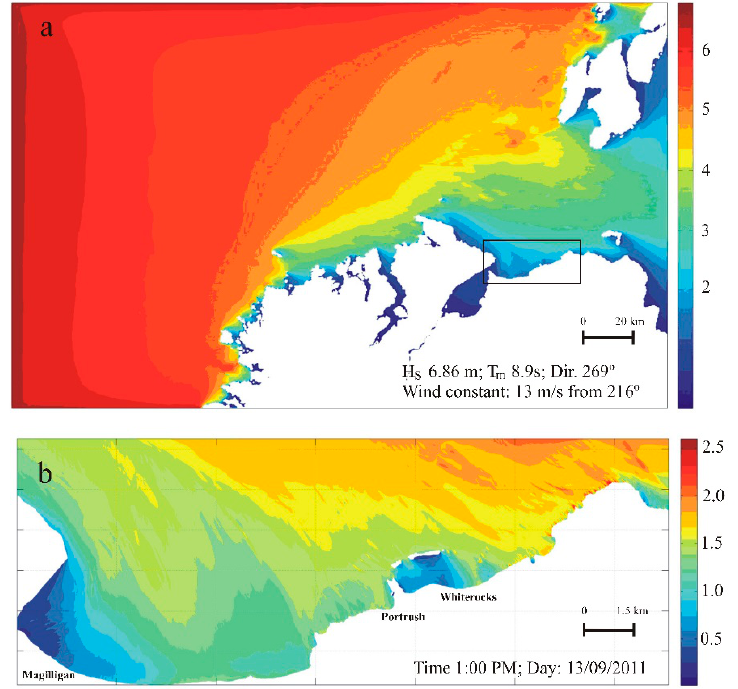
Figure 3. Modeled wave heights (m) for peak offshore storm conditions ( a ) and nearshore wave heights (m) ( b ) during above offshore wave conditions.